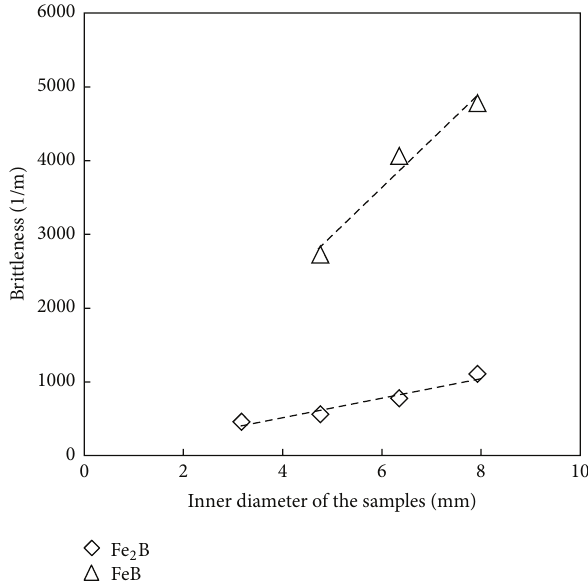
Figure11:Behaviorofthebrittlenessofthelayersasafunctionofthe boron potential represented by the inner diameter of the B phases as a function 2